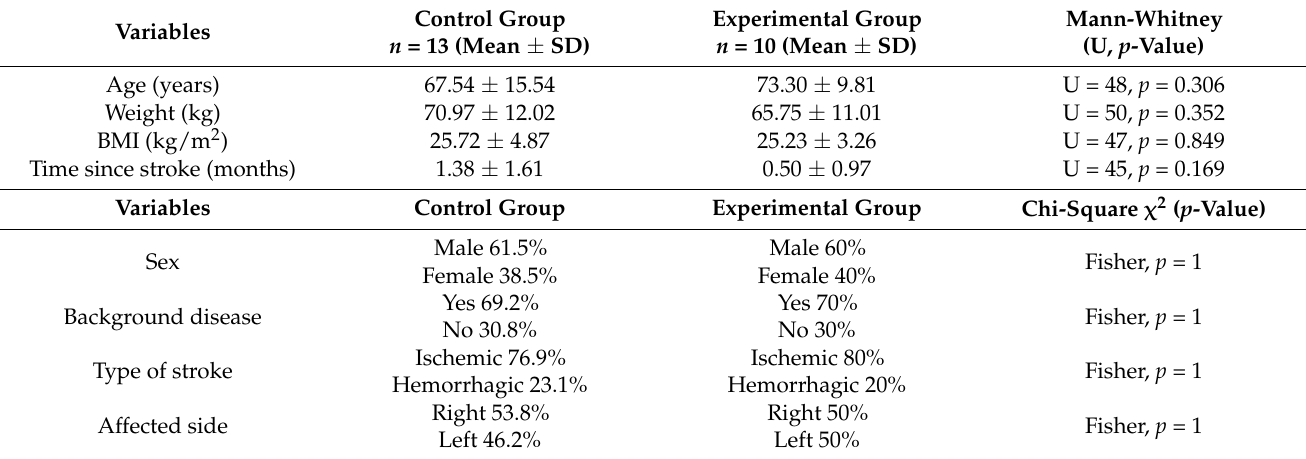
Table 1. Background characteristics (demographic and stroke characteristics) of the subjects per group.